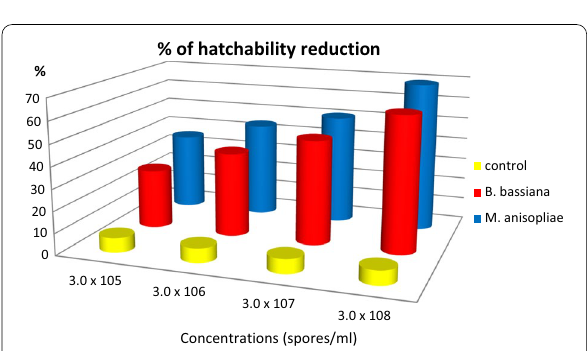
Fig. 2 Percentage reduction in E. cautella egg hatchability after treated with the tested concentrations of B. bassiana and M.